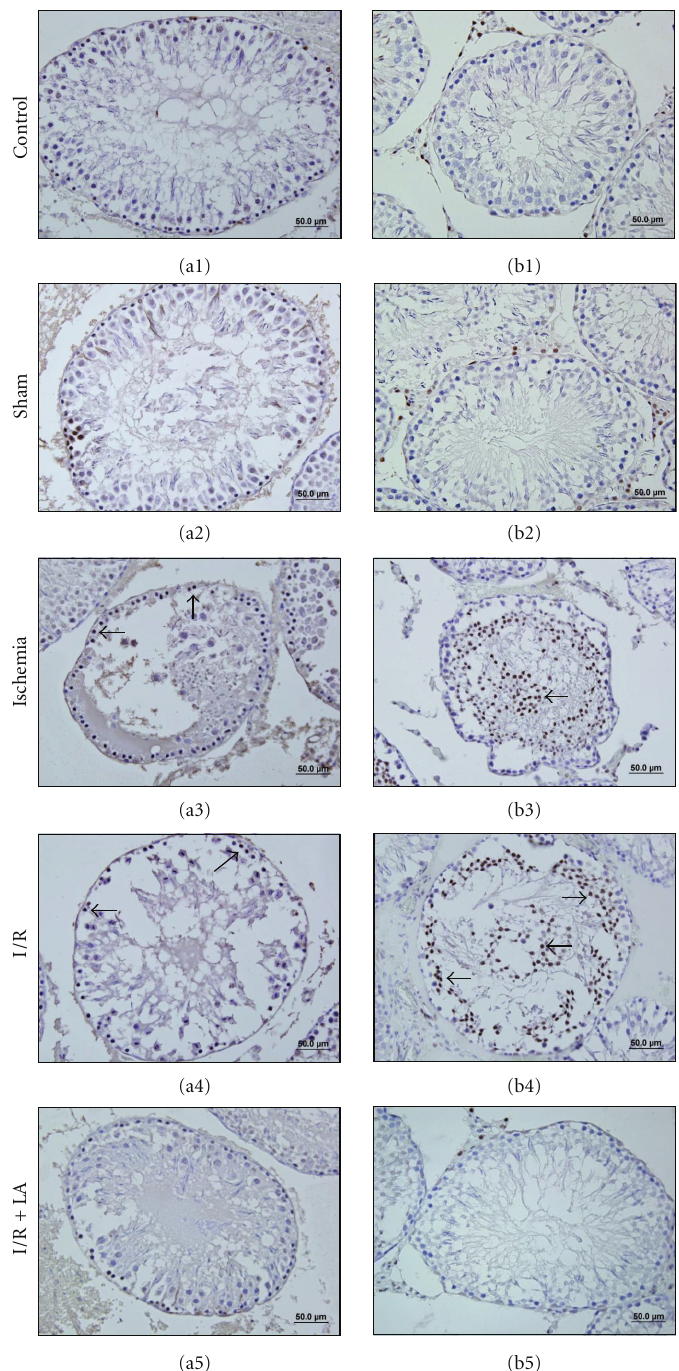
Figure 5: E ff ects of ischemia/reperfusion and LA (100mg/kg ip, 30minutes prior to detorsion) on germ cell apoptosis, TUNEL (a1–5), and active caspase-3 immunoreactivity (b1–5) in the testis tissue. TUNEL-positive and caspase-3-positive cells enhanced in the I (a3–b3) and I/R groups (a4–b4). LA pretreatment significantly reduced the number of apoptotic cells (a5–b5). Arrows indicate TUNEL-positive and caspase-3-positive